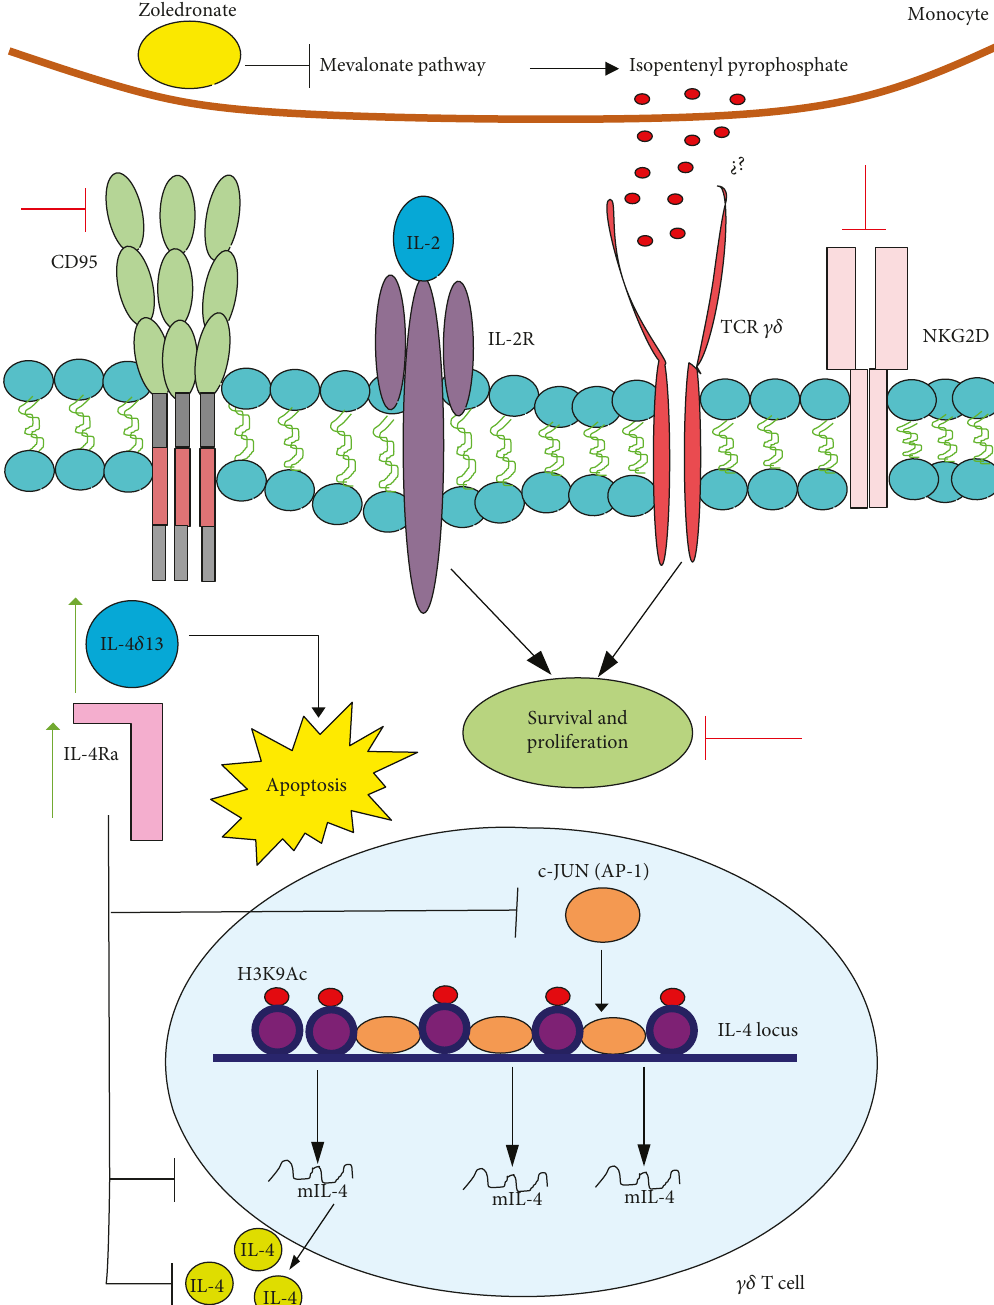
Figure 9: VPA induces apoptosis and inhibits IL-4 production in T γδ lymphocytes. The proliferation of T γδ lymphocytes arising from PBMC cultures, which are stimulated with IL-2 and zoledronic acid, is related to the promotion by the latter of the inhibition of the mevalonate pathway in monocytes, which upregulates pyrophosphate isopentenyl. This molecule is probably identi fi ed by the TCR of lymphocytes, but this has not been demonstrated. Furthermore, IL-2 sends proliferation and survival signals to these cells. However, VPA inhibits those mechanisms by promoting an increase in the intracellular molecules IL-4 δ and IL-4R α , which have a direct e ff ect on the 13 induction of apoptosis and on the inhibition of IL-4 by blocking the AP1 signaling pathway. One additional VPA-related e ff ect is the increase in H3 acetylation at the IL-4 locus, as well as a reduction in both CD95 and NKG2D. Green arrows indicate the processes, molecules, or mediators in the signaling pathway that are augmented and/or promoted by VPA. Red arrows indicate processes, molecules, or mediators in the signaling pathway that are inhibited by VPA. Figure based on